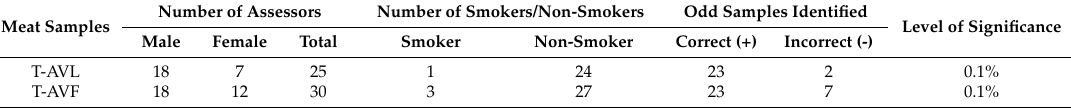
Table 5. Sensorial analysis of beef patties formulated with powdered leaves and flowers of A. vulneraria T-AVL (treatment with A. vulneraria leaf), T-AVF (treatment with A. vulneraria flower). Number of Assessors Number of Smokers/Non-Smokers Odd Samples Meat Samples